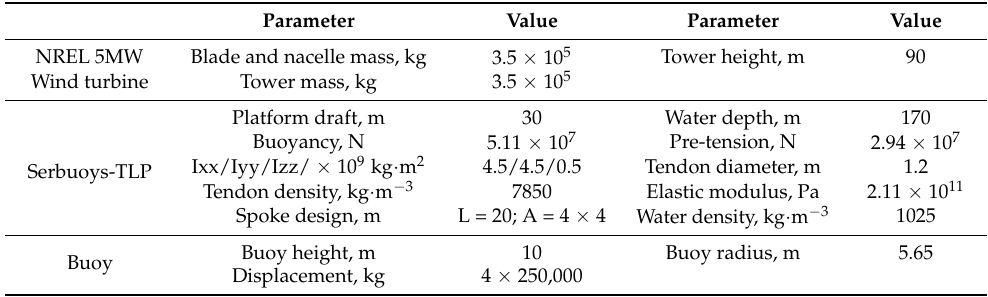
Table 1. Main parameters of the wind turbine, the Serbuoys-TLP, and the buoys. Parameter Value Parameter Value NREL 5MW Blade and nacelle mass, kg